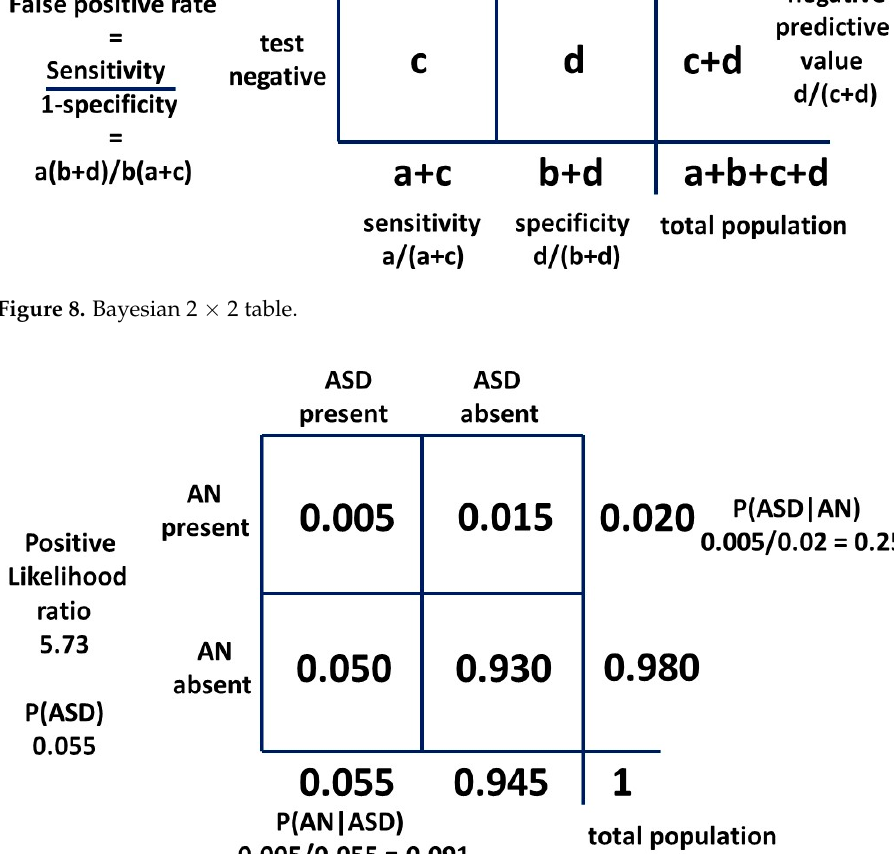
Figure 9. Bayesian 2x2 table for female model one as probabilities.